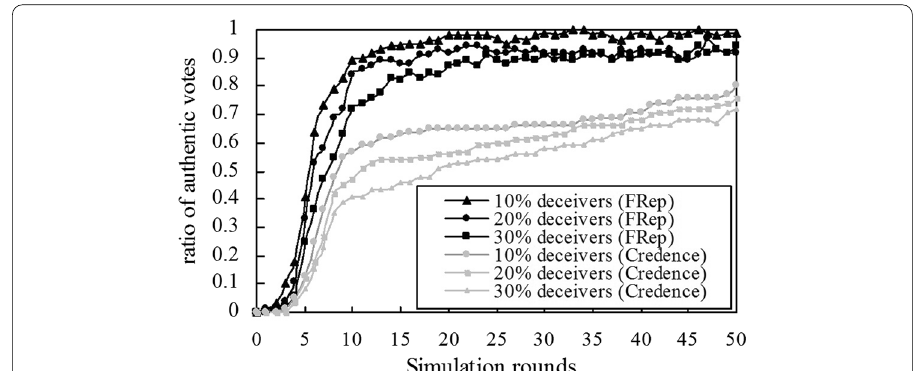
Fig. 6 Security protocol of evaluation feedback process. To verify the ability of the system to resist false evaluations, we compared our FRep system and Credence models through simulation experiments. 500, 1000 and 1500 false evaluation nodes were introduced, respectively, to provide false evaluation for all services. Among them, the number of collaborative services in the network is 10,000. LVR of each node has 2–3 random determination evaluations at the beginning of the simulation. Each simulation experiment runs